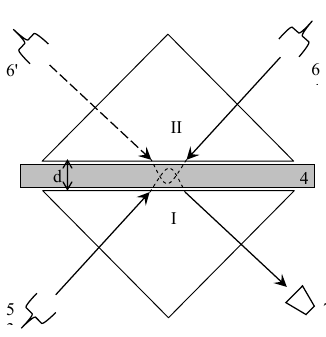
Fig. 2. Schematic of near-field interferential microwave sensing with using